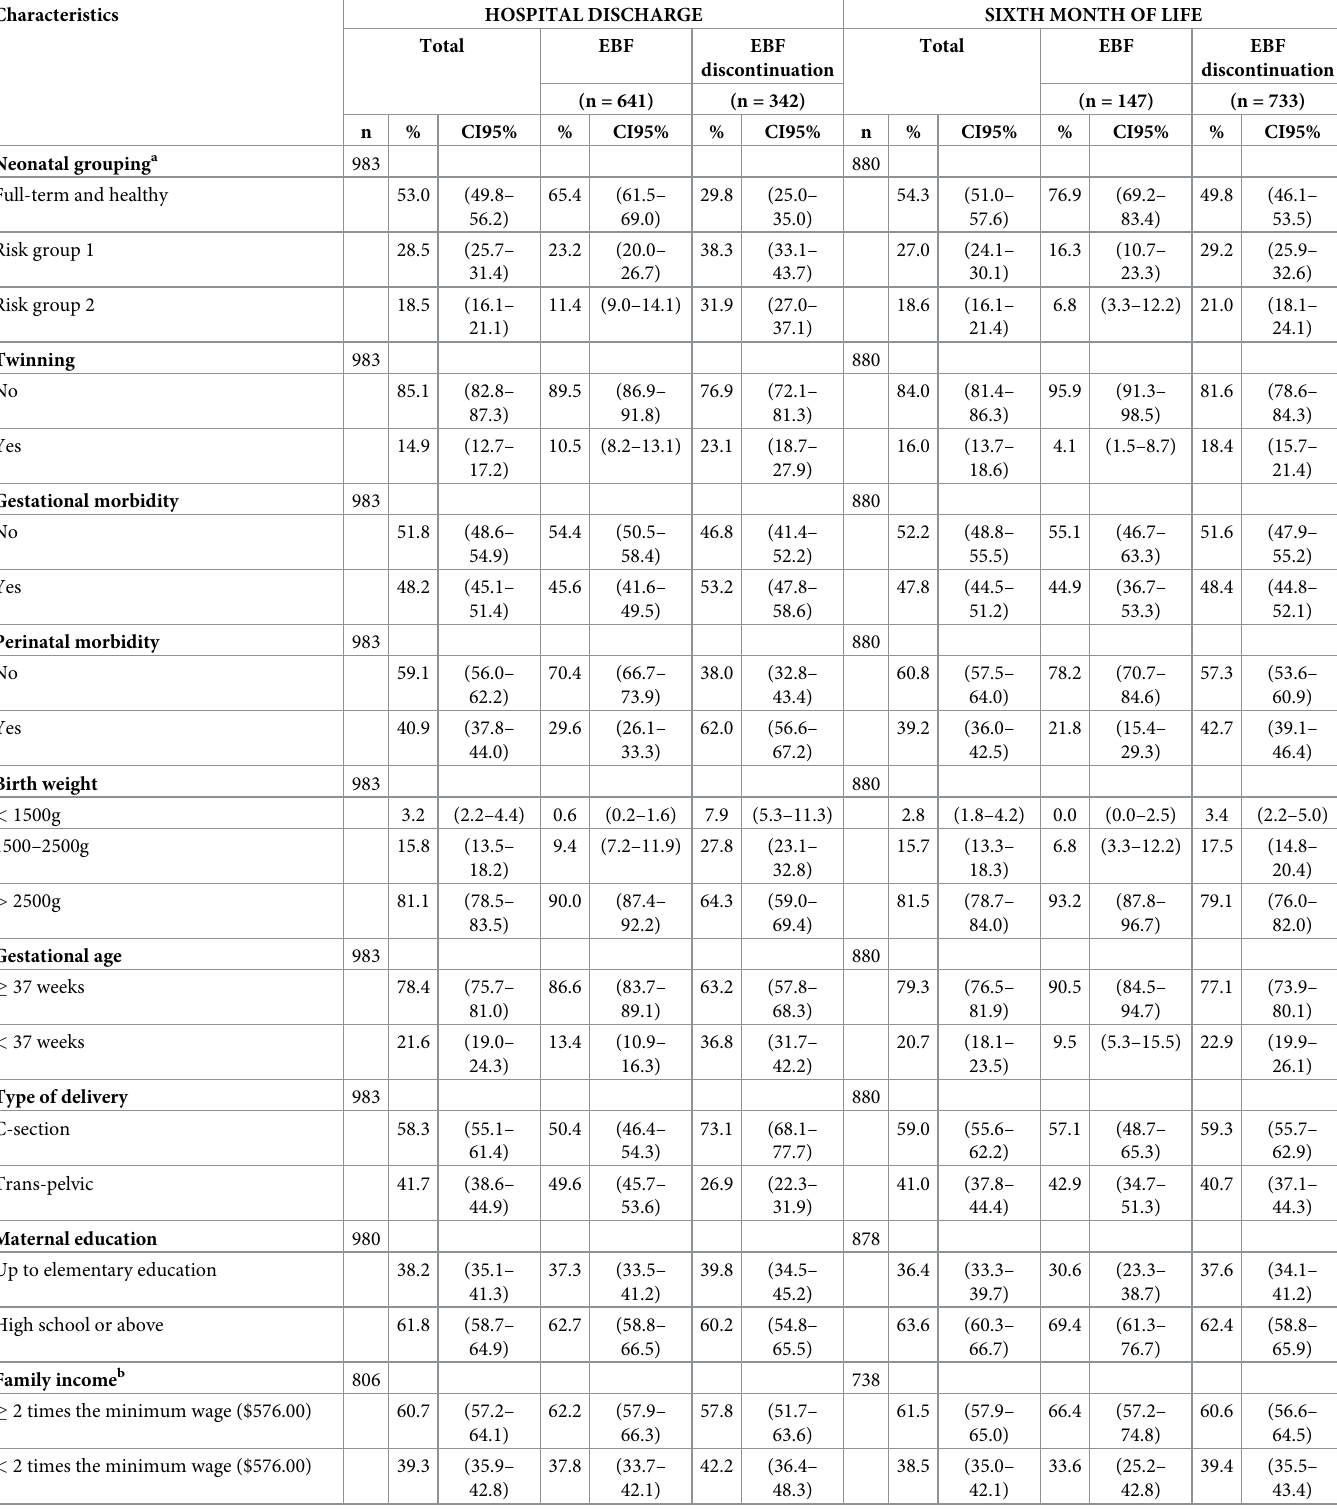
Table 1. Characterization of the study population by feeding practice at hospital discharge and at six months of life, Rio de Janeiro, RJ, Brazil, 2018.